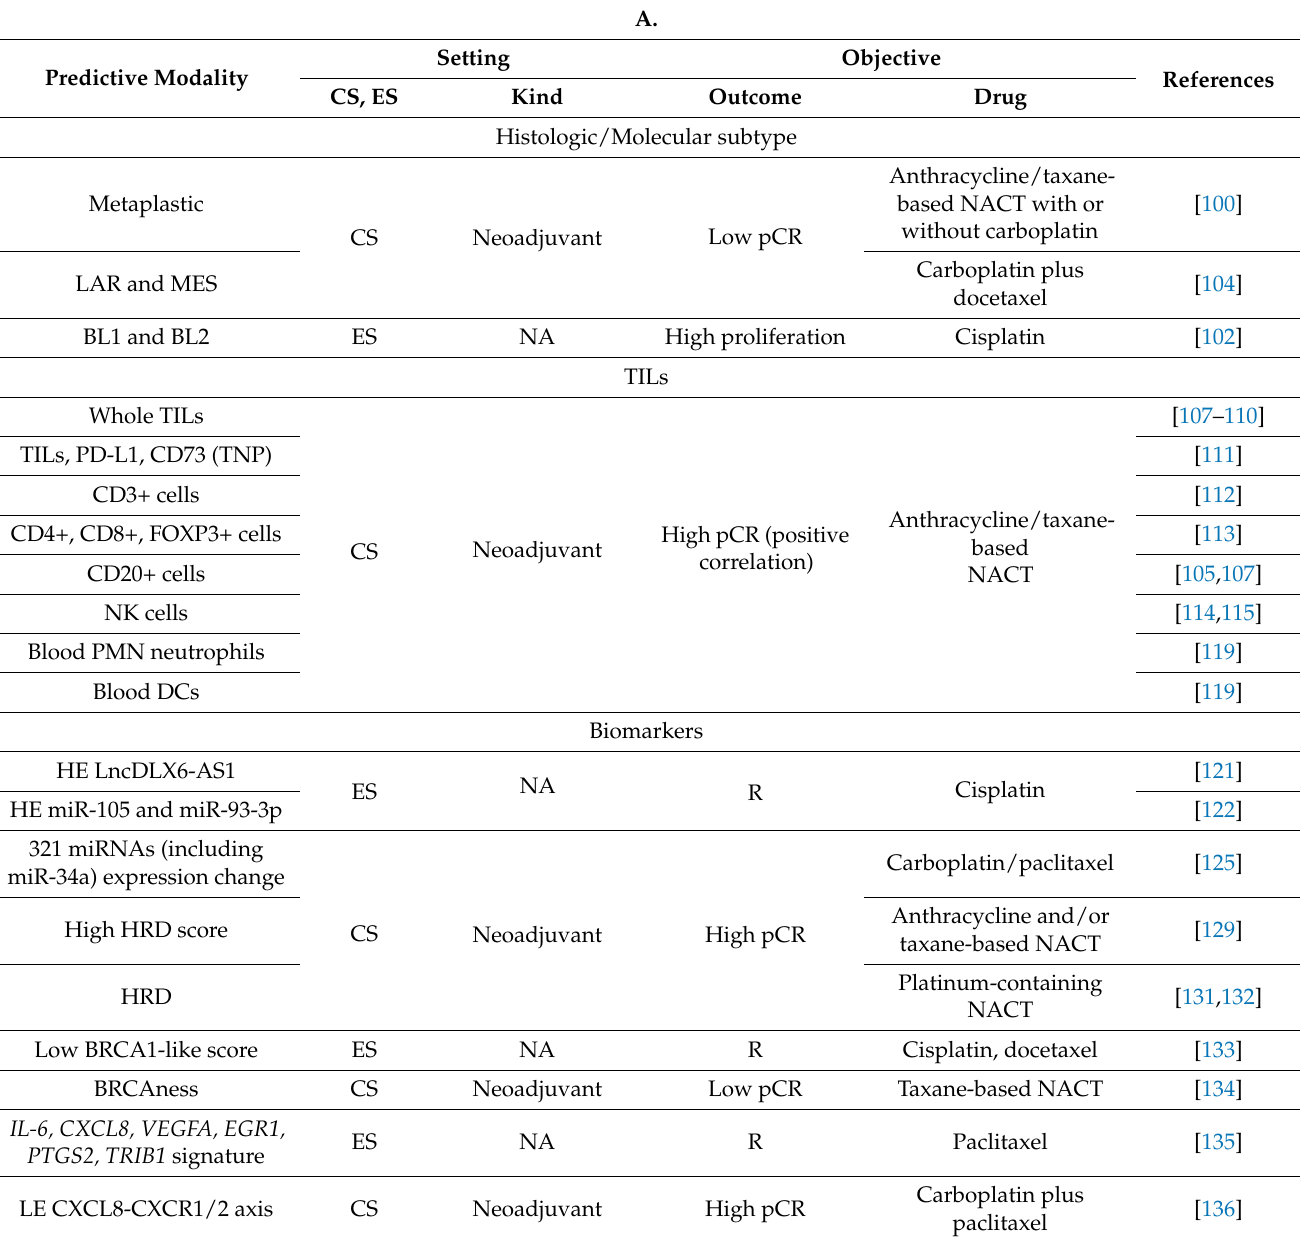
Table 2. Prediction of response or resistance (R) to chemotherapy (CT) in TNBC. B. Prediction of response or R to chemotherapy (CT) in